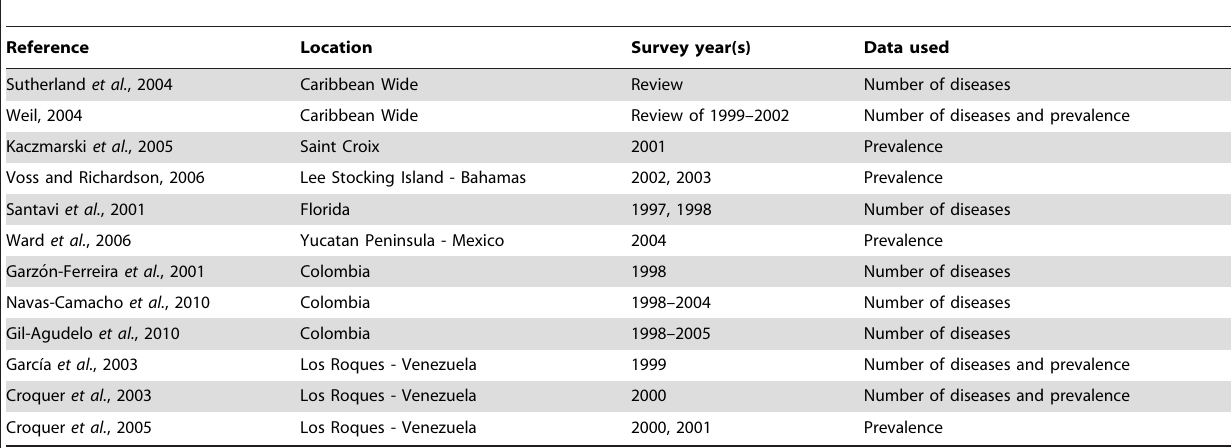
Table 2. List of references, reports and reviews of coral disease parameters from various locations in the Caribbean used to obtain data for the 14 species used in the phylogenetic signal estimates.